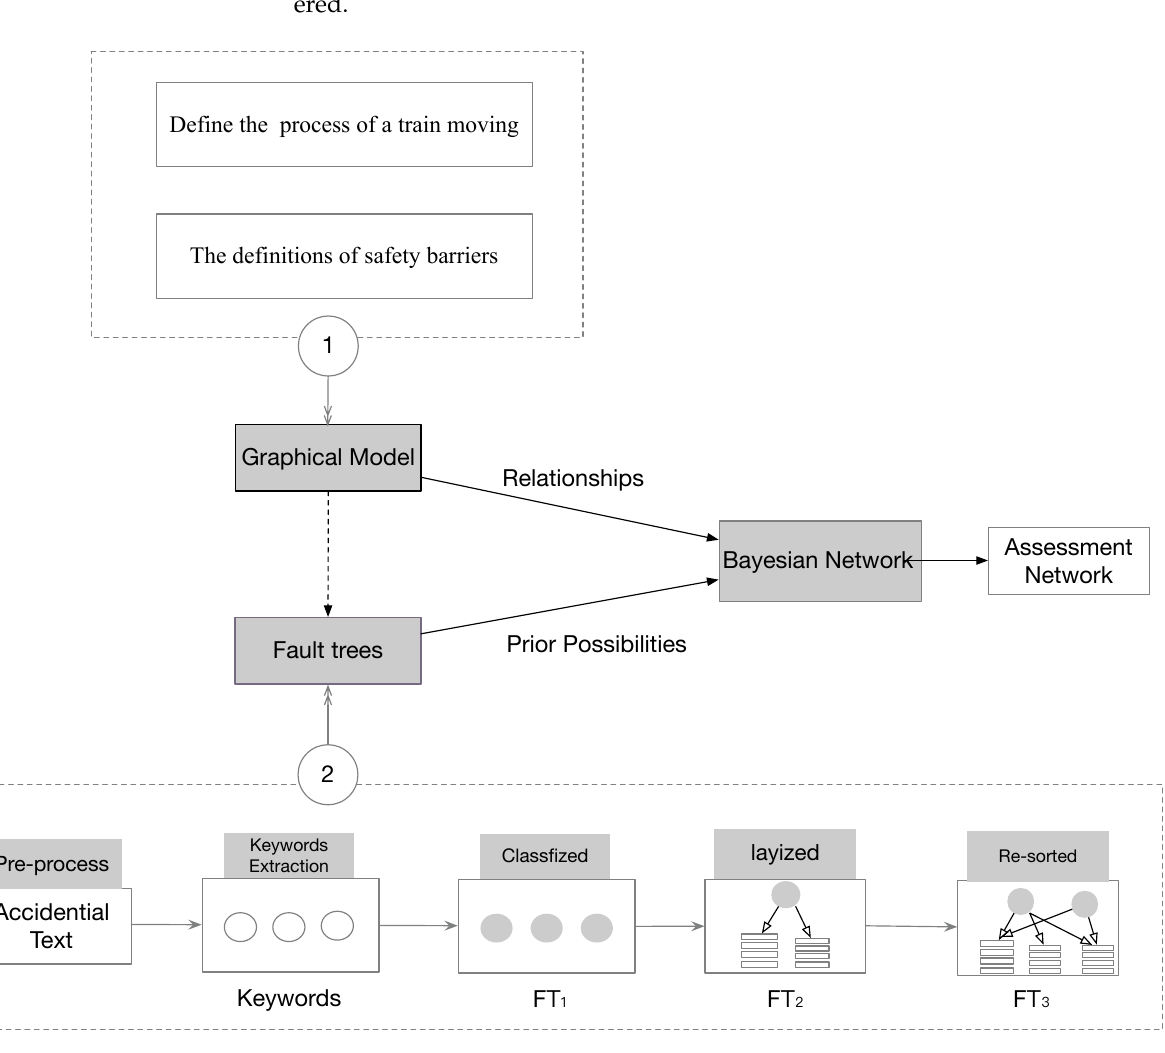
Figure 1. Framework of the proposed